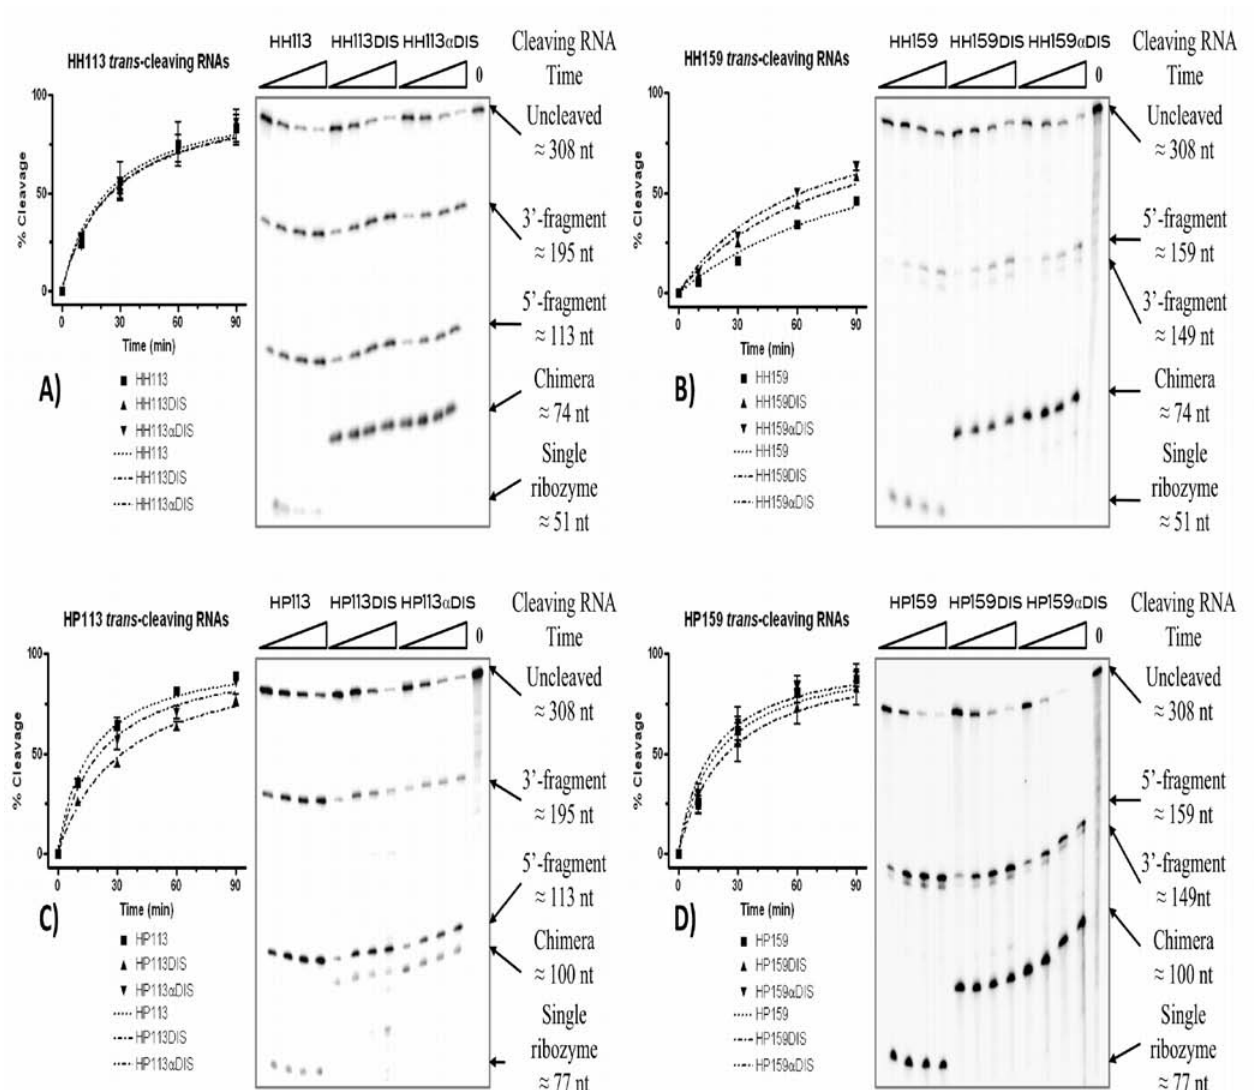
Figure 2. Cleavage reactions of 5’UTR by ribozymes and chimeric RNA molecules. Each gel autoradiograph shows a representative cleavage reaction time course of a specific ribozyme and its respective DIS and α DIS derived chimeras: (a) HH113, (b) HH159, (c) HP113 and (d) HP159. Each experiment was performed in triplicate and the cleavage percentage was obtained by quantification of the cleavage products. Curves were fitted with maximum sqr(R)